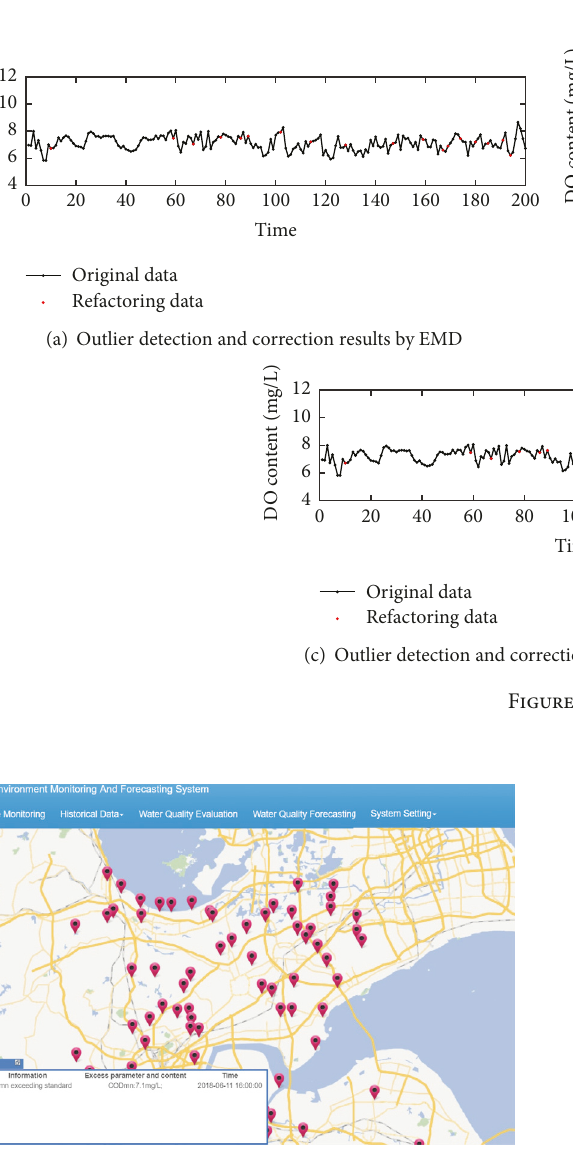
Figure 24: The location of water quality monitoring stations.